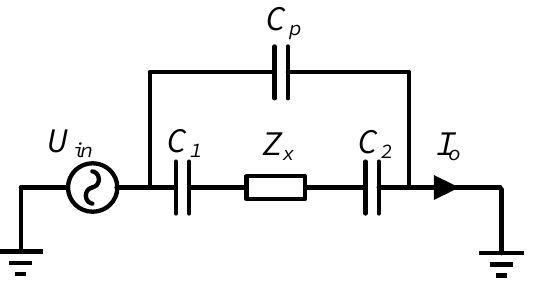
Figure 6. The equivalent circuit in the simulation analysis.